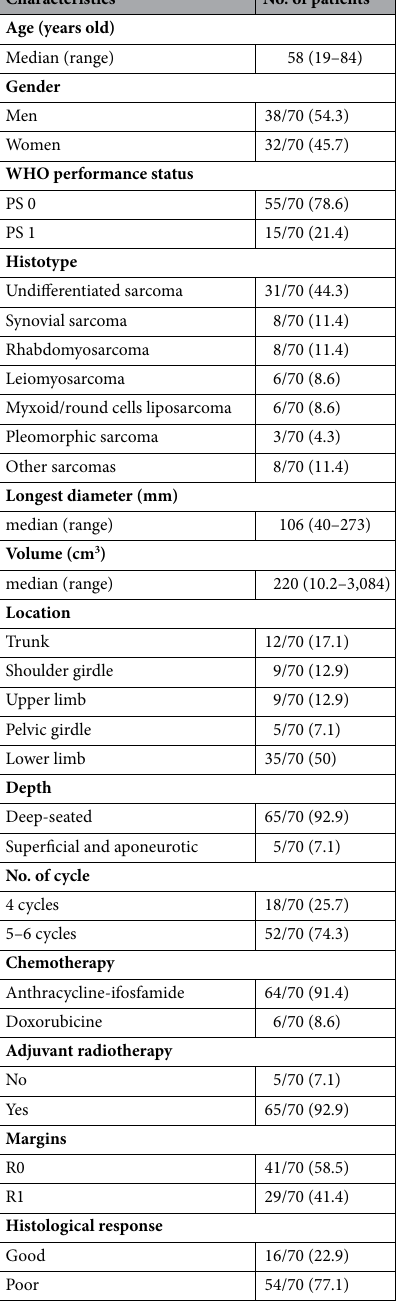
Table 1. Clinical and pathological features of the study population. Results are number of patients with percentage in parentheses, except for age, longest diameter and volume that are expressed as median with range in parentheses. WHO PS World health organization performance